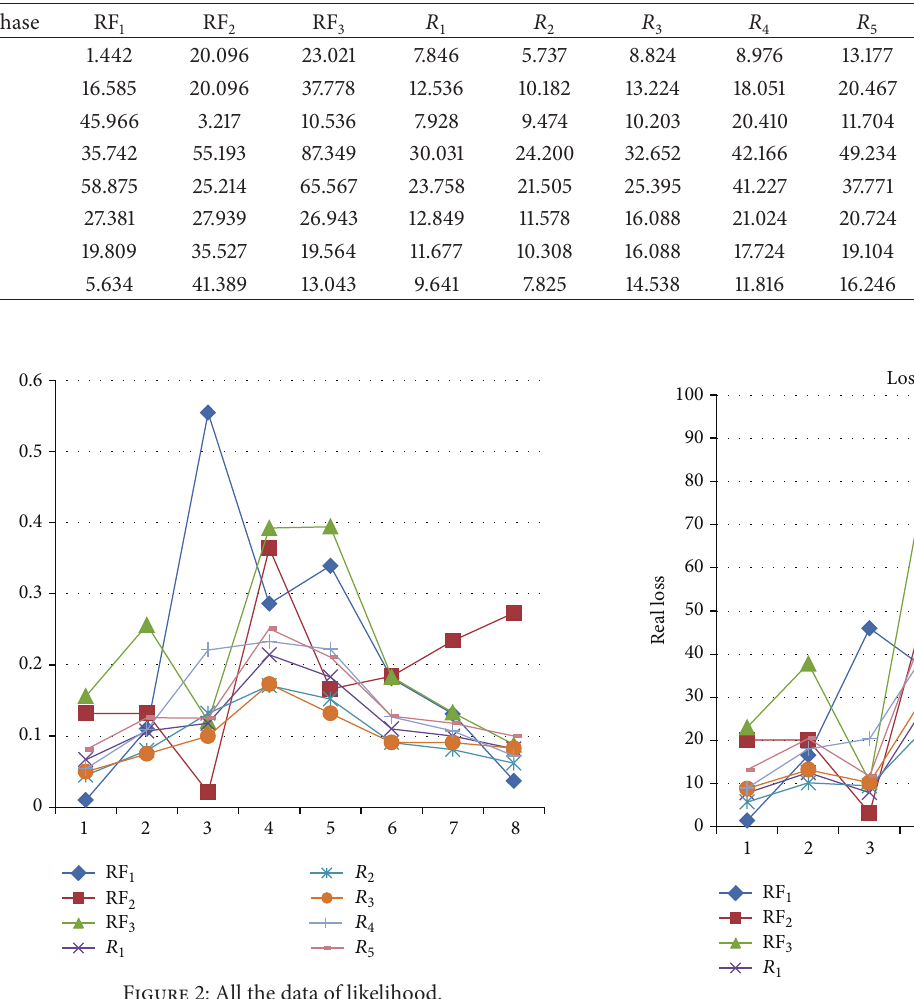
Figure 3: All the data of actual